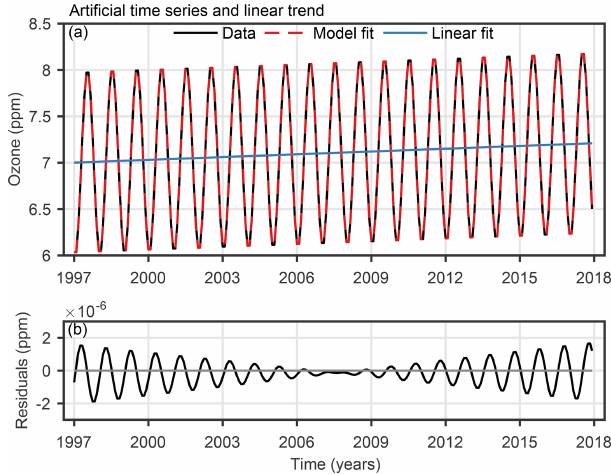
Figure 5. (a) Artificial ozone time series (composed of a simple seasonal cycle and a linear trend) and its model fit and linear trend estimation. (b) Trend model residuals (data − model